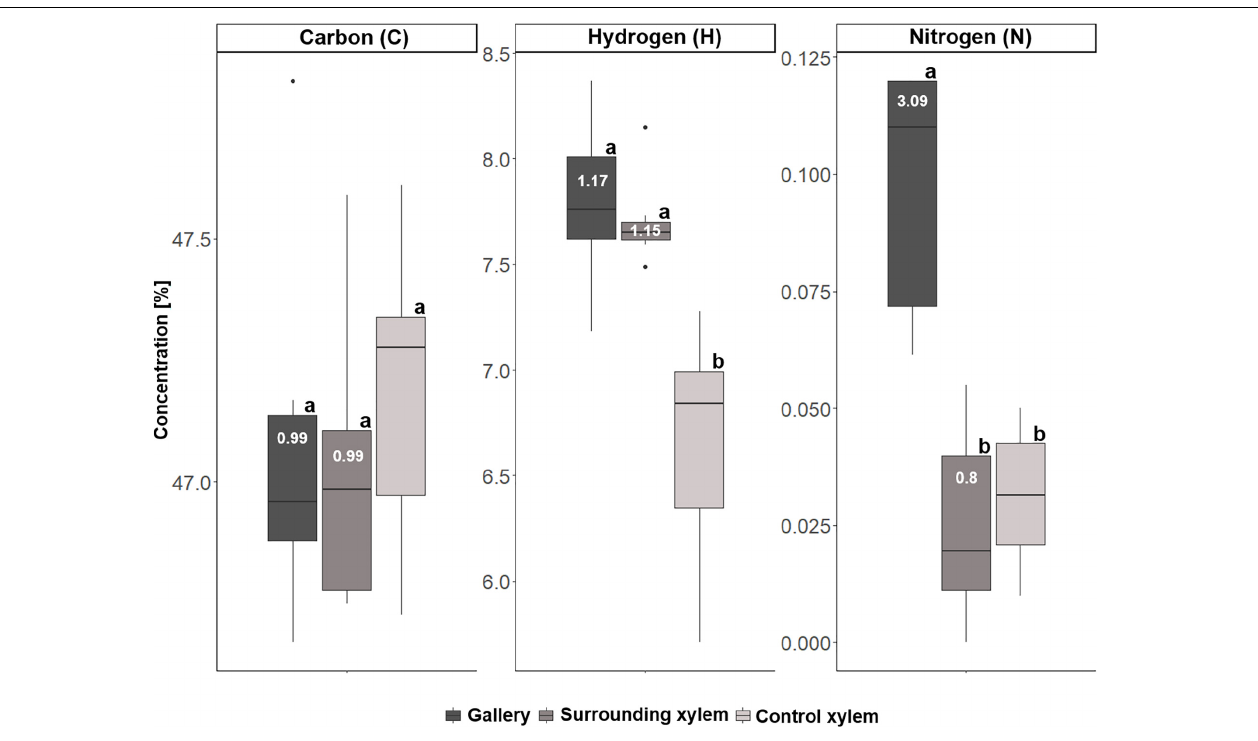
FIGURE 9 | Concentrations of carbon (C), hydrogen (H), and nitrogen (N) the three types of samples taken from Trypodendron lineatum ( N = 5–8 per group): (i) gallery, (ii) xylem next to gallery, and (iii) control xylem. Different letters next to boxplots (a, b) indicate significant differences between the respective group per individual element. Enrichment ratios (white numbers) for treatment i and ii were added to boxplots for each